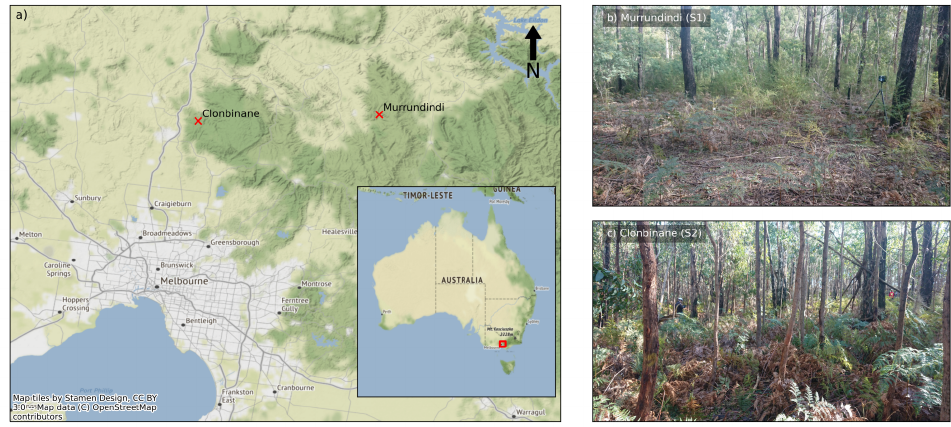
Figure 1. ( a ) Locations of the two sites (shown as red crosses) relative to Melbourne, Australia and example photographs of typical vegetation found at ( b ) Murrundindi (S1) and ( c ) Clonbinane (S2)